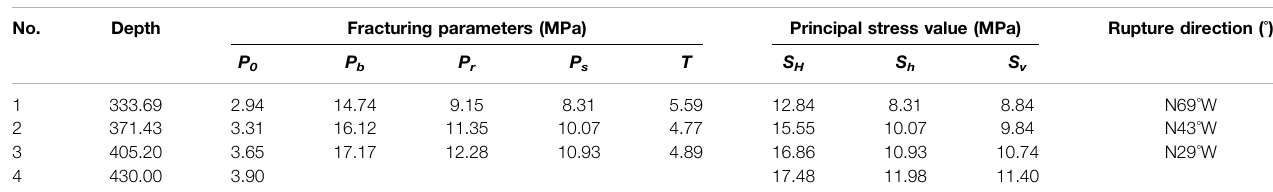
TABLE 2 | Results of hydraulic fracturing ground stress in YL tunnel DZ-YL-08 hole.